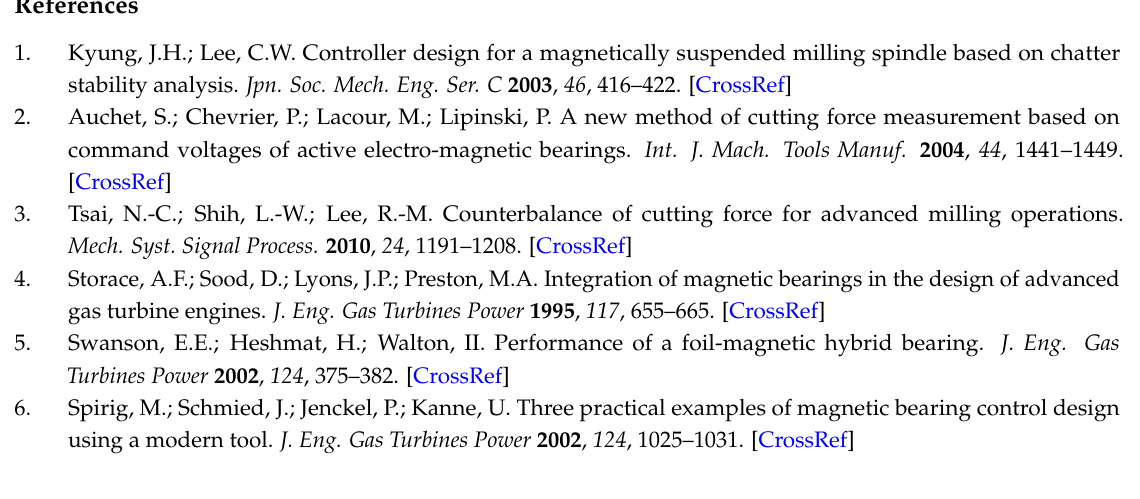
Figure 22. Micrograph of finished workpiece (copper).